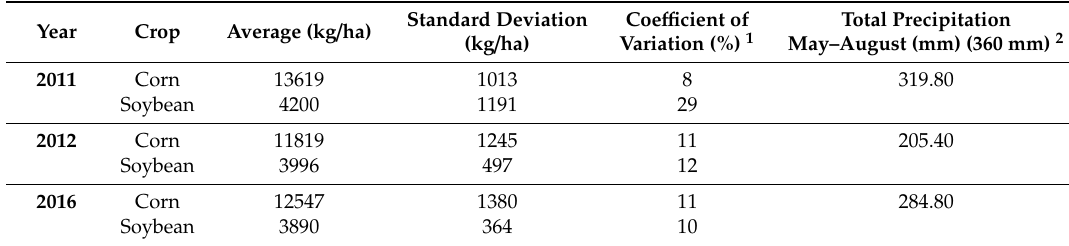
Table 1. Summary statistics of corn and soybean yields for years of study.